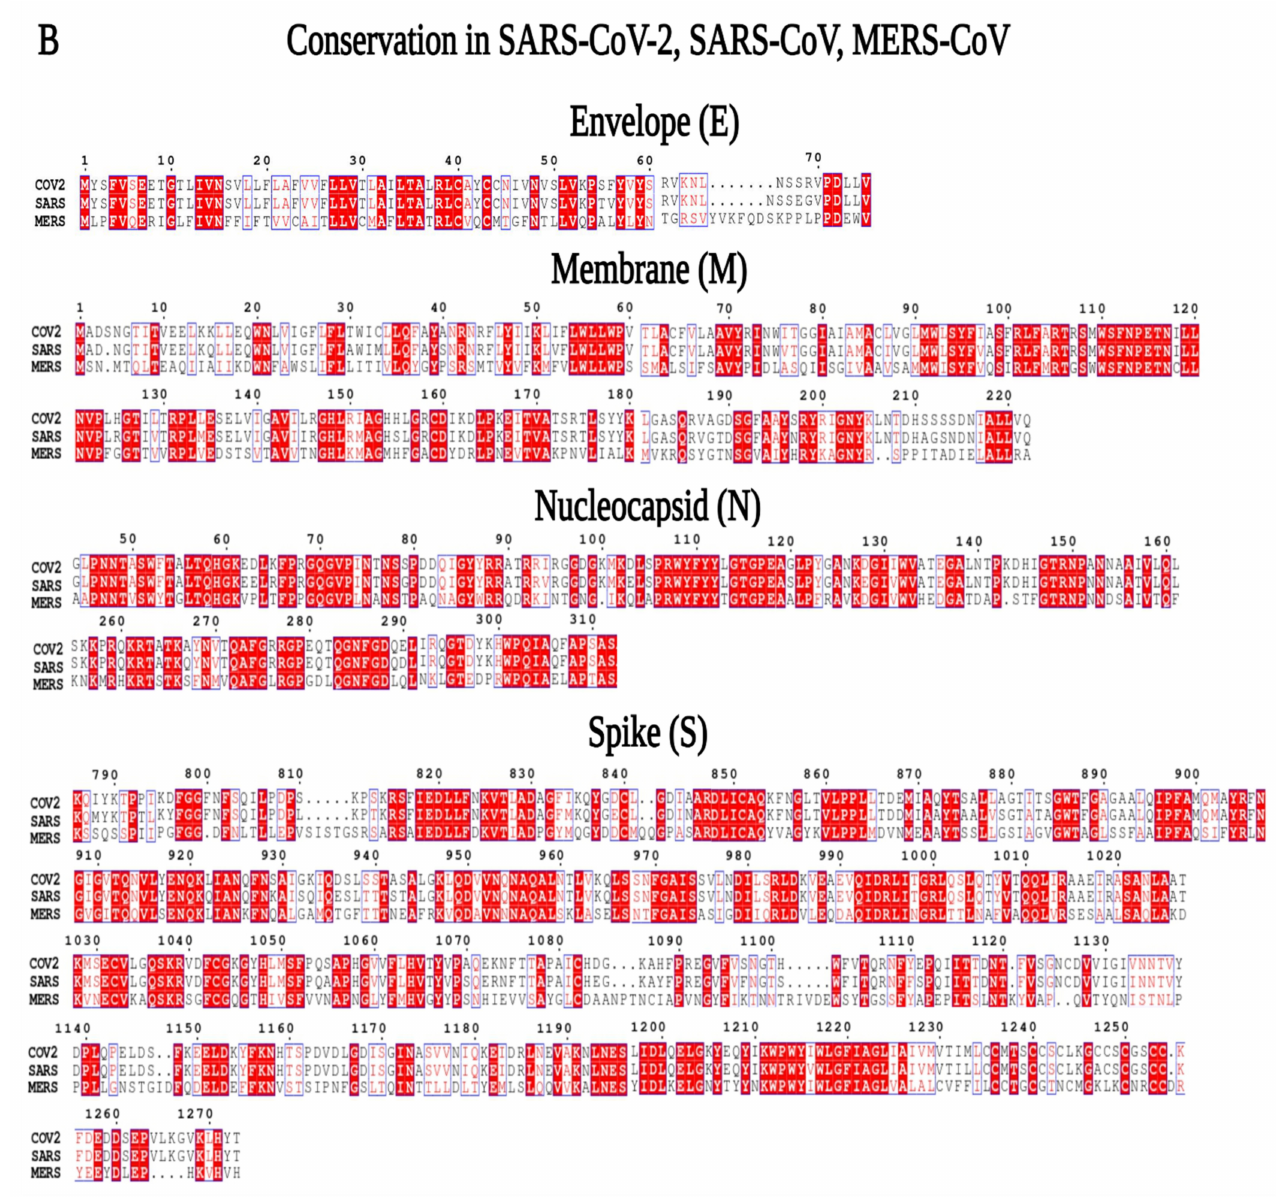
Figure 2. Conservation of envelope (E), membrane (M), nucleocapsid (N), and spike (S) protein sequences in seven HCoVs and in SARS-CoV-2, SARS-CoV, and MERS-CoV. Conservation of E, M, N, and S proteins in ( A ) seven HCoVs and ( B ) SARS- CoV-2 (COV2), SARS-CoV (SARS), and MERS-CoV (MERS). Only the regions showing conservancy are presented for N and S proteins (full length sequences are shown in Supplementary Figures). Images are shown from ESPript results. Conserved regions are colored in